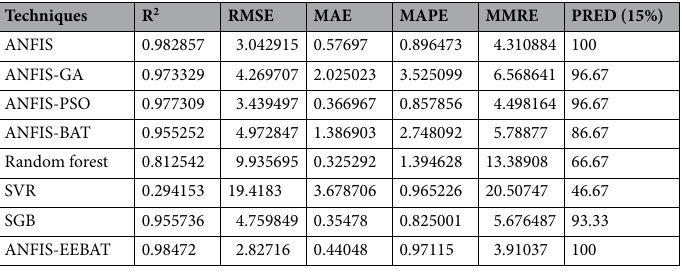
Table 8. Results on ZKmS with other techniques.